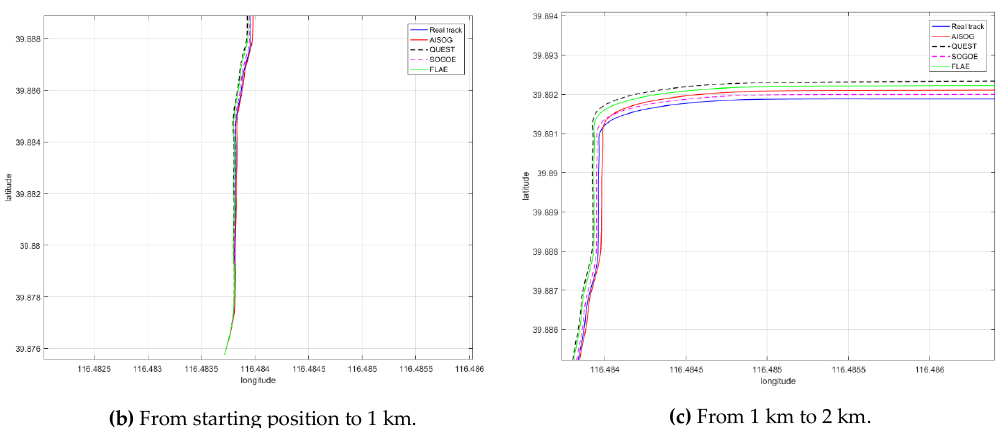
Figure 11. The position estimation results of the four alignment methods and real trajectory.